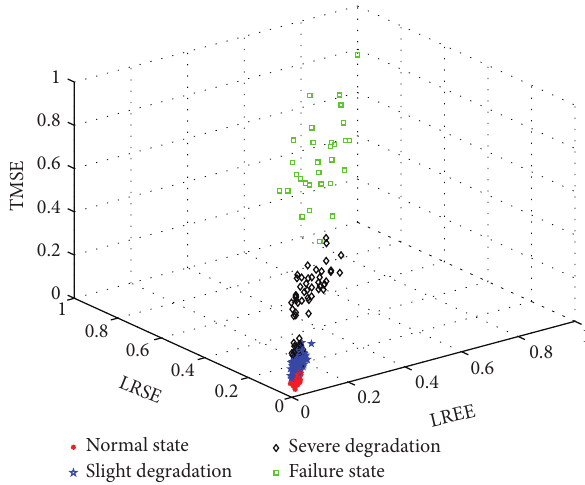
Figure 7: Space distribution of entropy features.